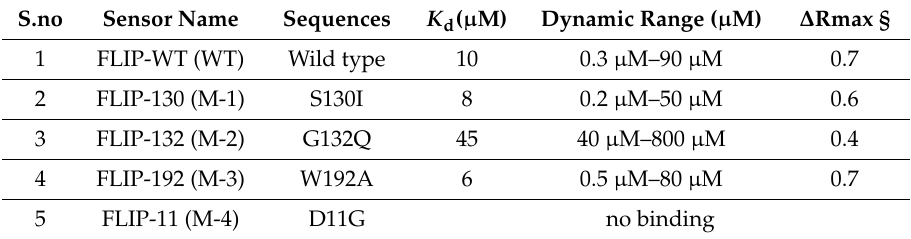
Figure 6. Titration analysis of the sensor protein. ( A ) In vitro emission ratio measurement by the FLIP-SP nanosensor. ( B ) In vitro ligand-dependent mVenus / ECFP emission ratio change of wild type (WT) and mutant sensors in the presence of di ff erent sulfate concentrations. Values are the means of three independent replicates. Vertical bars show the standard deviation. Table 1. FLIP-SP wild type (WT) and